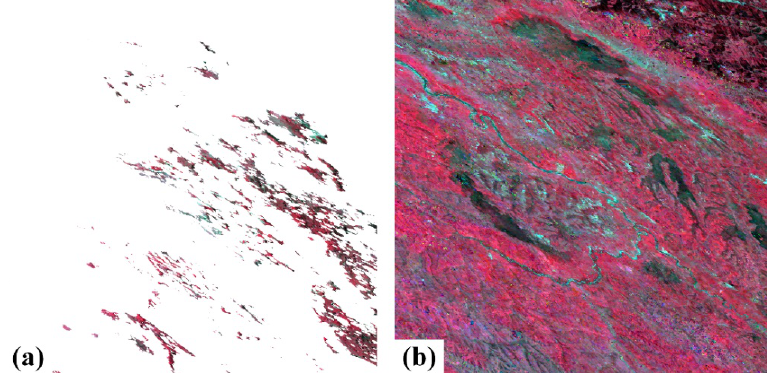
Figure 3. ( a ) Original and ( b ) gap-filled Landsat OLI image on 19 August 2017. The cloudy pixels in the original image were masked out.